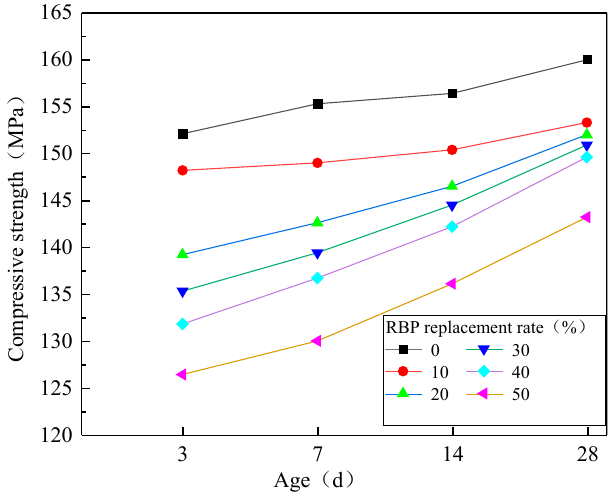
Figure 5. Changes in compressive strength of RBP UHPC with age.